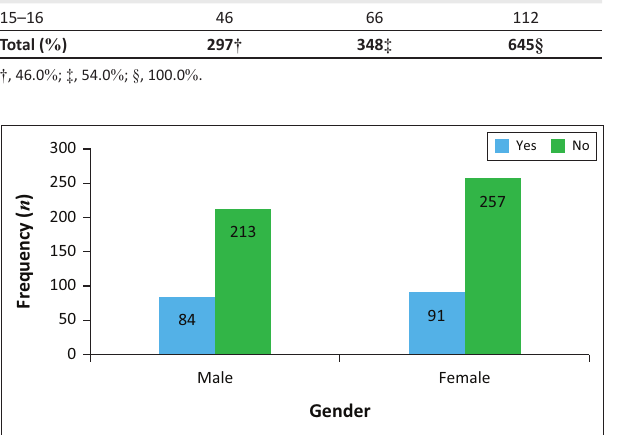
FIGURE 2: Frequency of previous ocular examination stratified for gender.